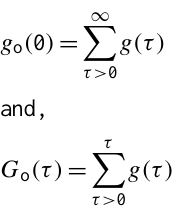
Fig. 4. (a) The relationship between feedback amplitude g and time constant τ estimated from the data shown in Fig. 2: MAGICC- GEBM with (black) and without (black-dashed) polar sink- ing; UVicESCM-EMIC (blue); GFDLR15a-AOGCM (red). The in- set shows the tail of the relationship in more detail. (b) The rela- tionship between the cumulative feedback amplitude G and τ . Here τ P G(τ) = g(τ) − 3 . 3. The inset shows the cumulative ocean heat τ = 0 uptake feedback amplitude G o (see